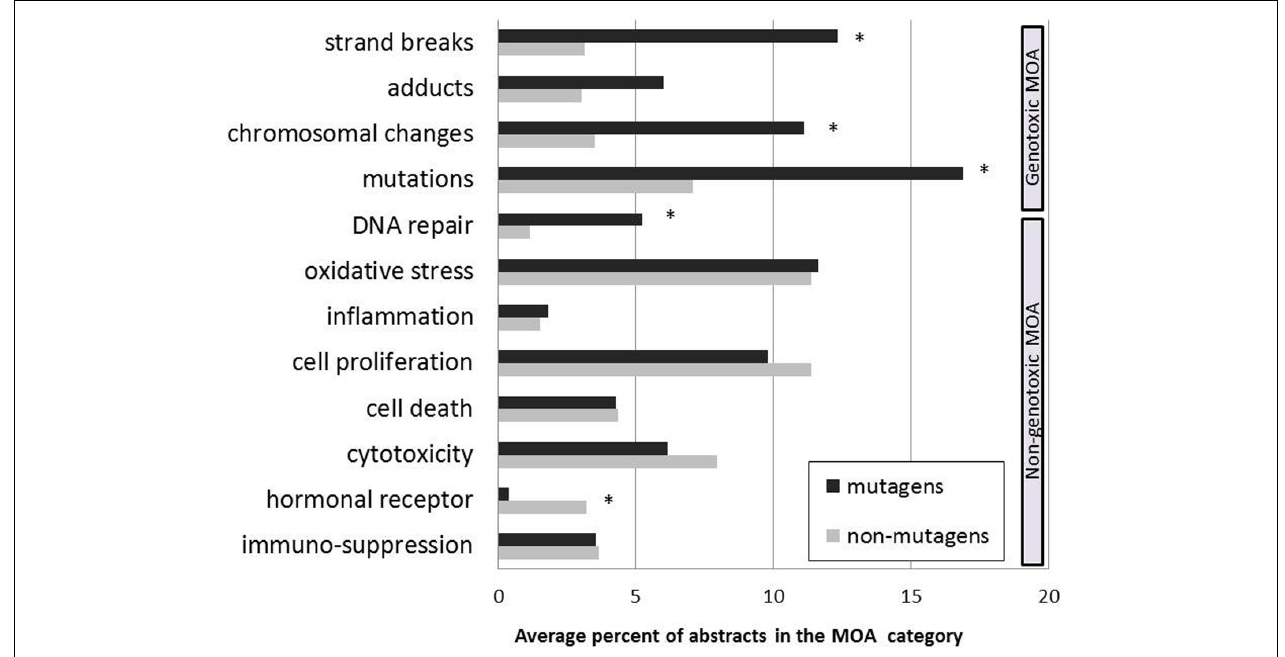
FIGURE 3 | Distribution of literature concerning mutagens and non-mutagens in the MOA taxonomy. Carcinogens were grouped into two groups (mutagens and non-mutagens) based on the results from QSAR modeling. Carcinogenic MOA profiles were generated for the two groups. The literature distribution is shown as the average percent of abstracts in the MOA category. ∗ Signficantly different compared to the other group ( p ≤ 0.05).